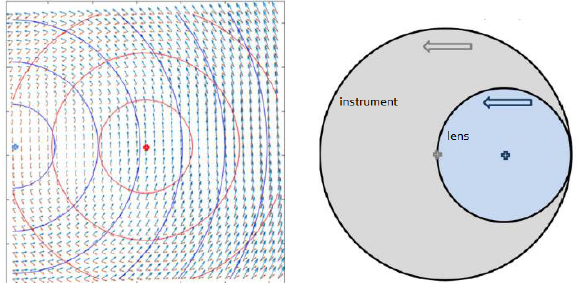
Fig. 4. Left, velocity vectors, blue color corresponds to tool, red to workpiece, crosses represent element centers, right, instrument and lens arrangement in Synchrospeed mode. The arrows indicate the direction of